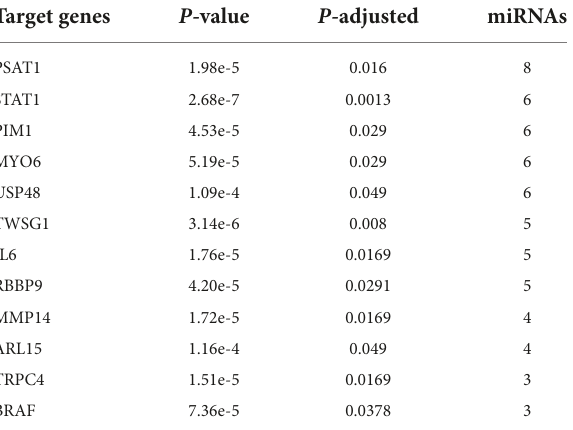
TABLE 6 Target gene of 41 dysregulated miRNAs. Target genes